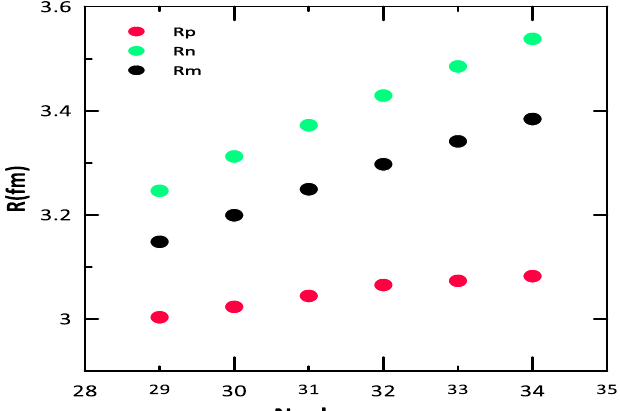
Fig. 3: The relation between radius and number of nucleon of 29-34 Mg